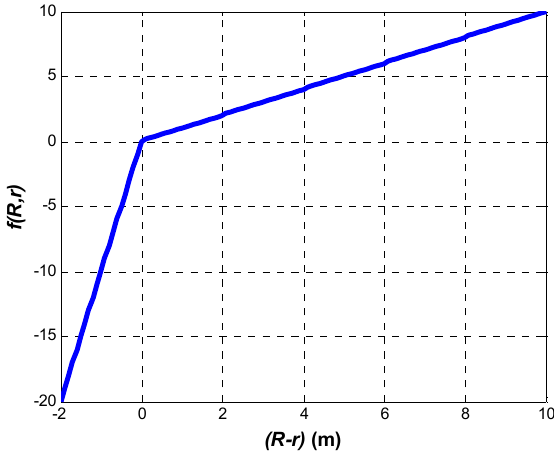
Figure 2. Example of the non-linear error function.